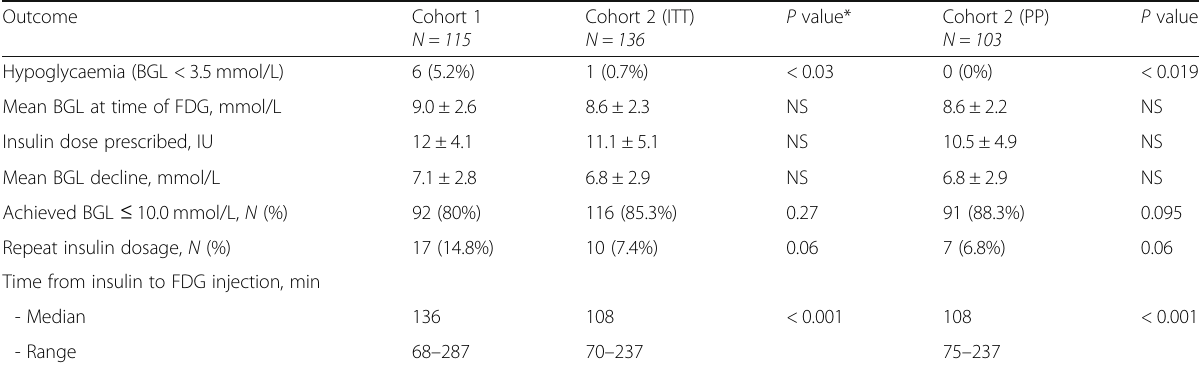
Table 3 Comparative results following insulin administration patients in Cohort 1, Cohort 2 (ITT) and Cohort 2 (PP) groups